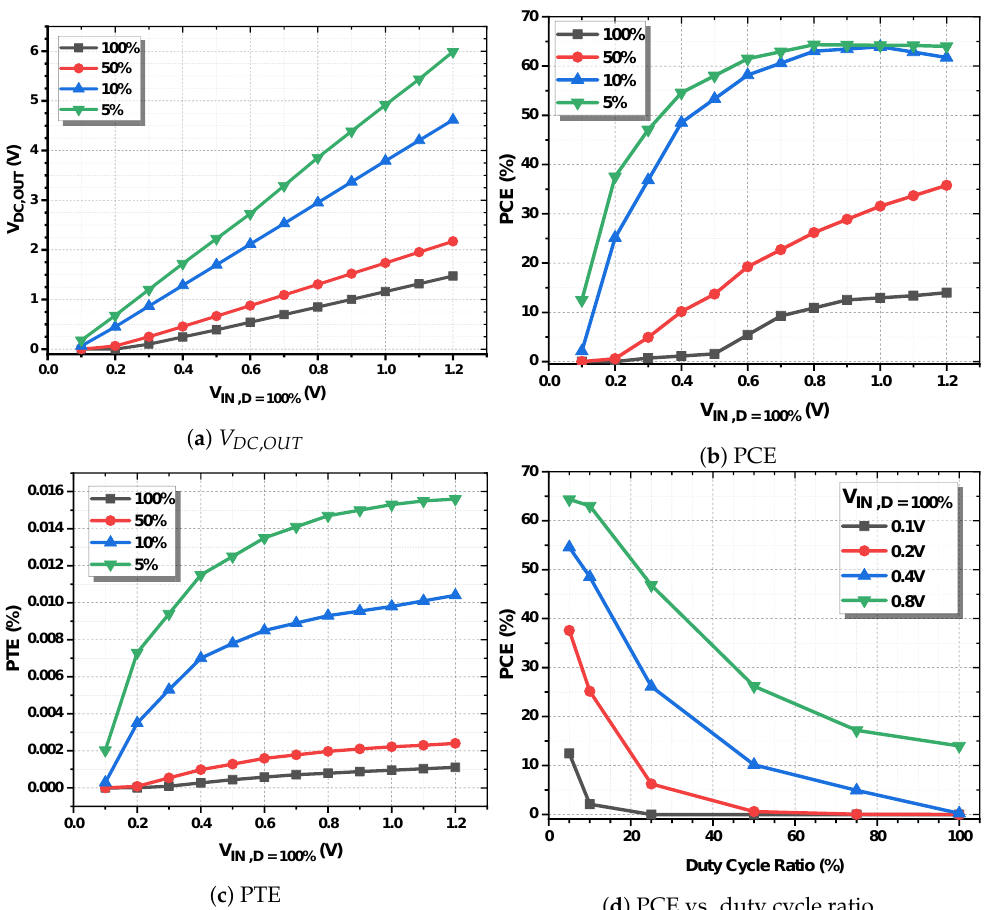
Figure 7. Simulation results of the rectifier and the WPT system for various duty cycle ratios for the same amount of RF input power. ( a ) V DC , OUT , ( b ) PCE, and ( c ) PTE over V IN , D = 100% . ( d ) PCE vs. duty cycle ratio for various V IN , D = 100% .